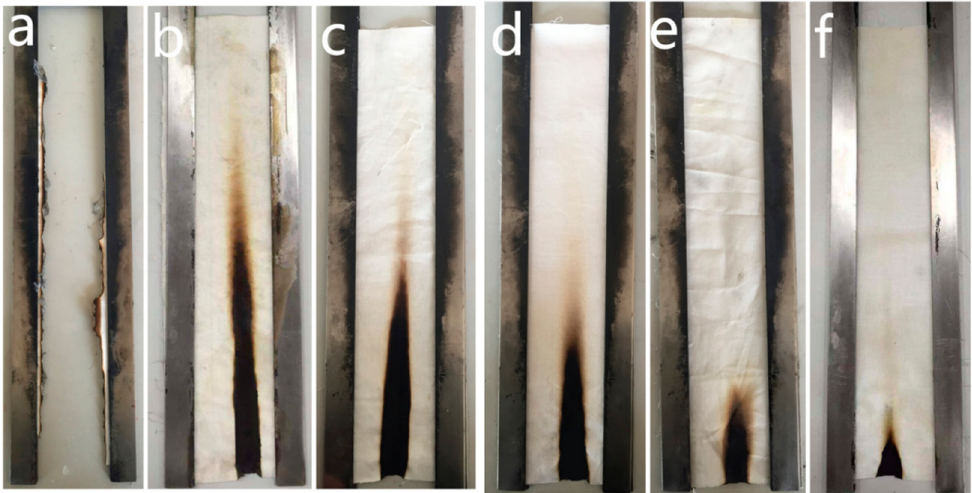
Figure 2. Vertical flammability test results of the cotton fabrics ( a ) and the cotton fabrics treated with 200, 250, 300, 350, and 400 g / L CPN-PDMS solutions ( b–f ).